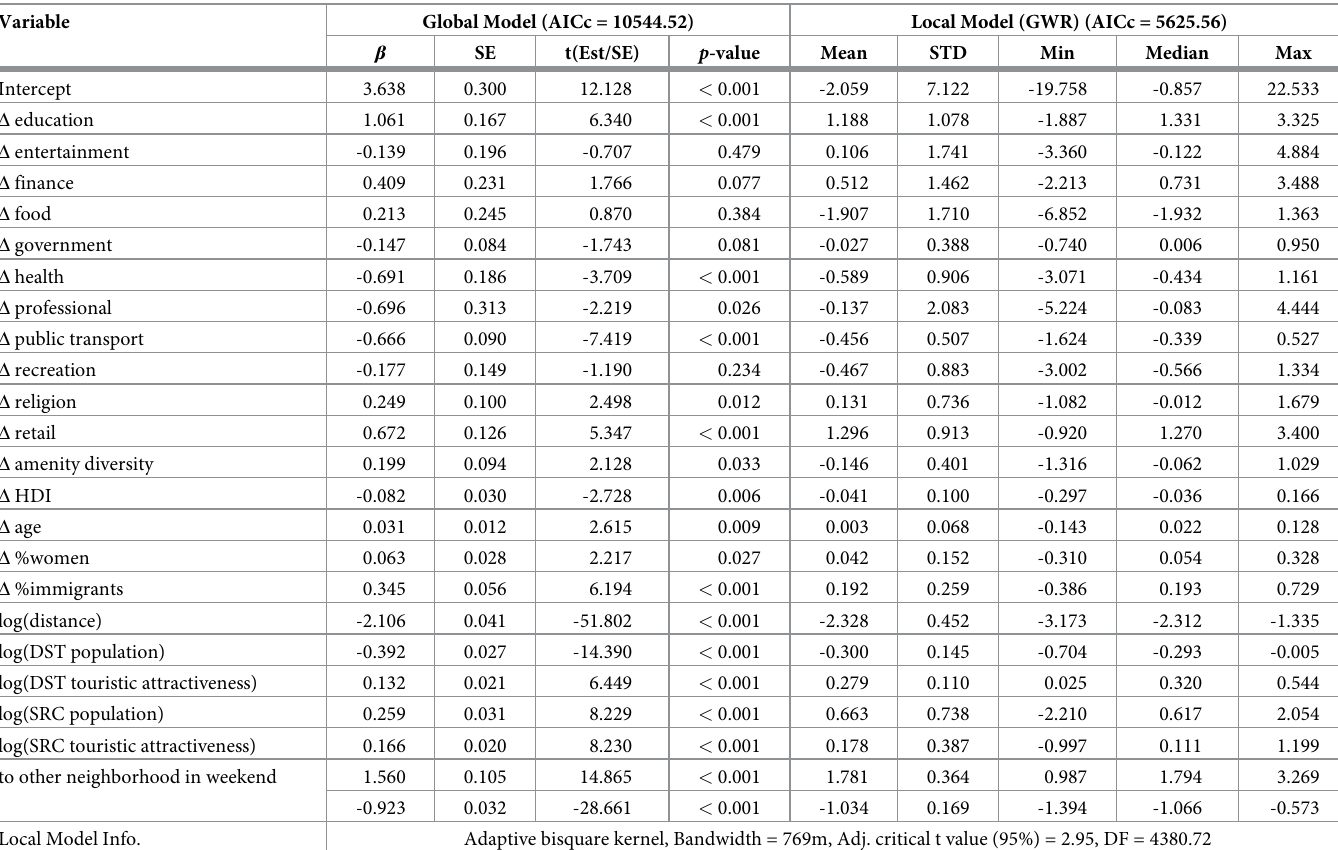
Table 1. Regression results in the global model (Negative Binomial regression) and the local model (GWR with GLM Negative Binomial regression).